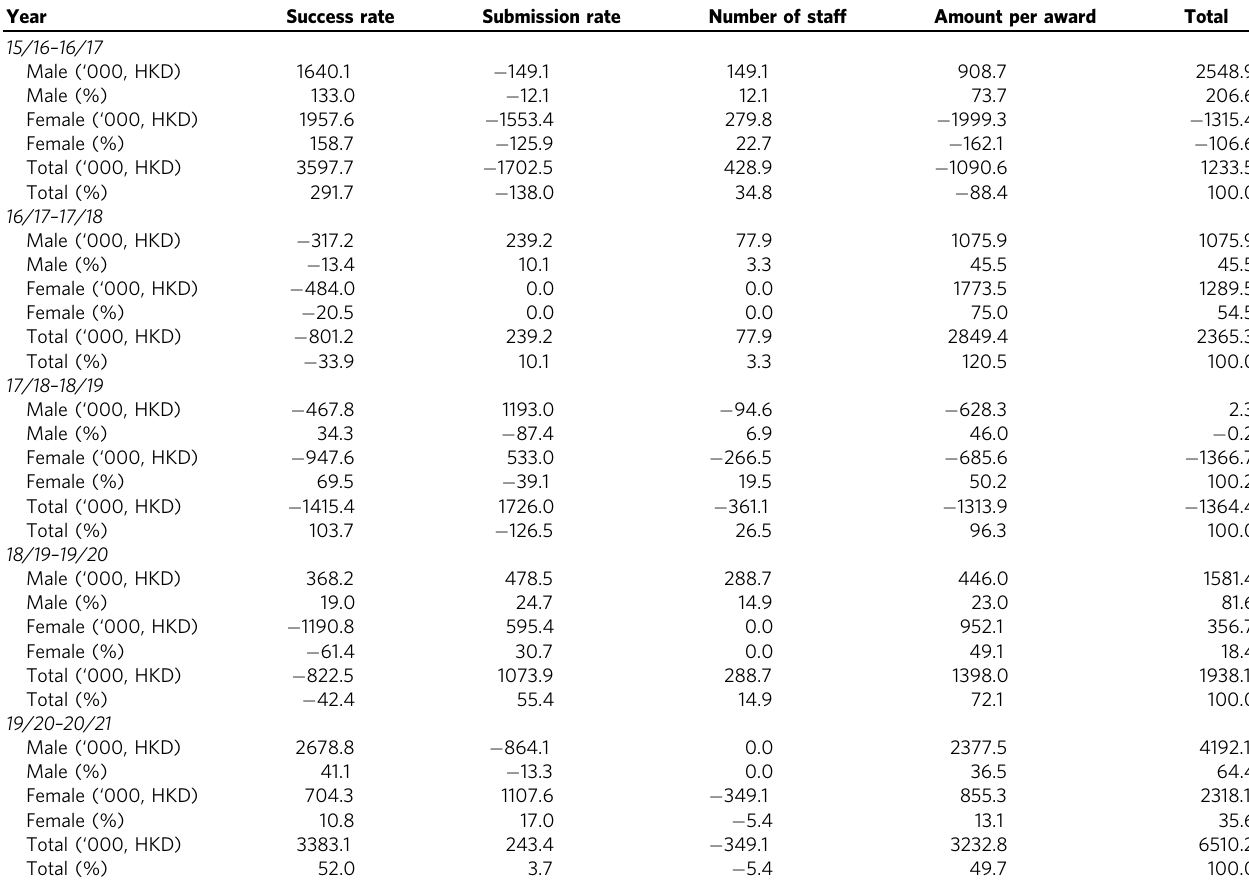
Table 3 Decomposition analysis for changes in the amount of awards ( ‘ 000,